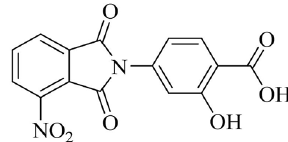
Figure 1. Chemical structures of 2-Hydroxy-4-(4-nitro-1,3-dioxoisoindolin-2-yl) benzoic acid